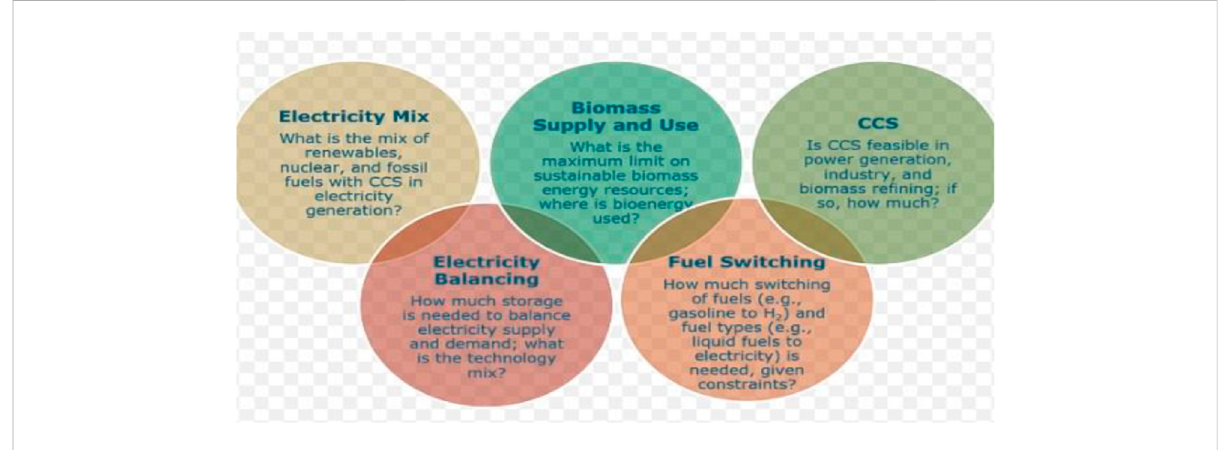
FIGURE 7 Decarbonizing solution applied for developing